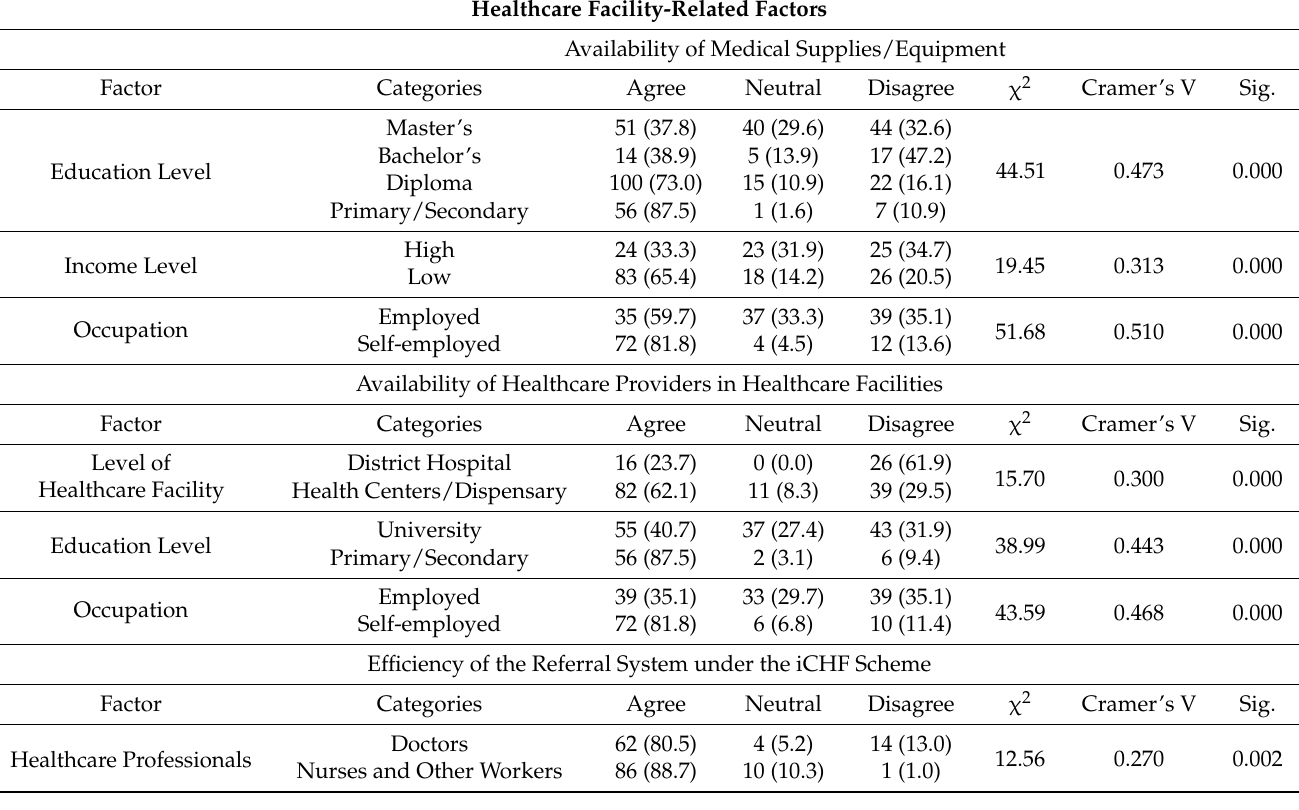
Table 3. Healthcare facility-related factors that affect the iCHF scheme, according to healthcare providers and community